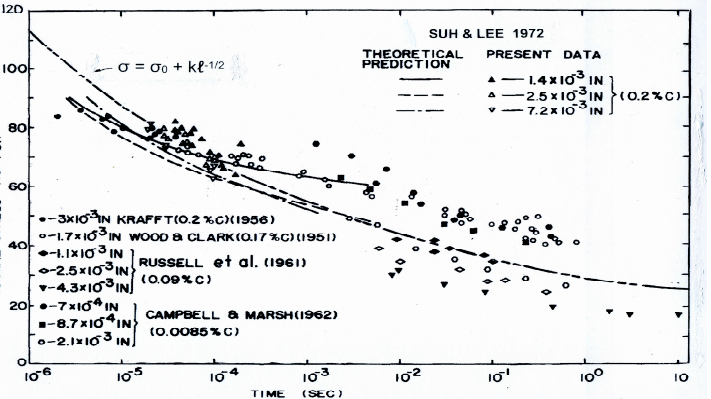
Figure 1. A compilation of delay time measurements for the yielding of carbon steel materials, also with several theoretical model predictions reported by Suh and Lee [9], and also including an extended curve for Hall–Petch dependence; 10 3 psi = 6.9 MPa and 1.0 in = 2.54 cm.